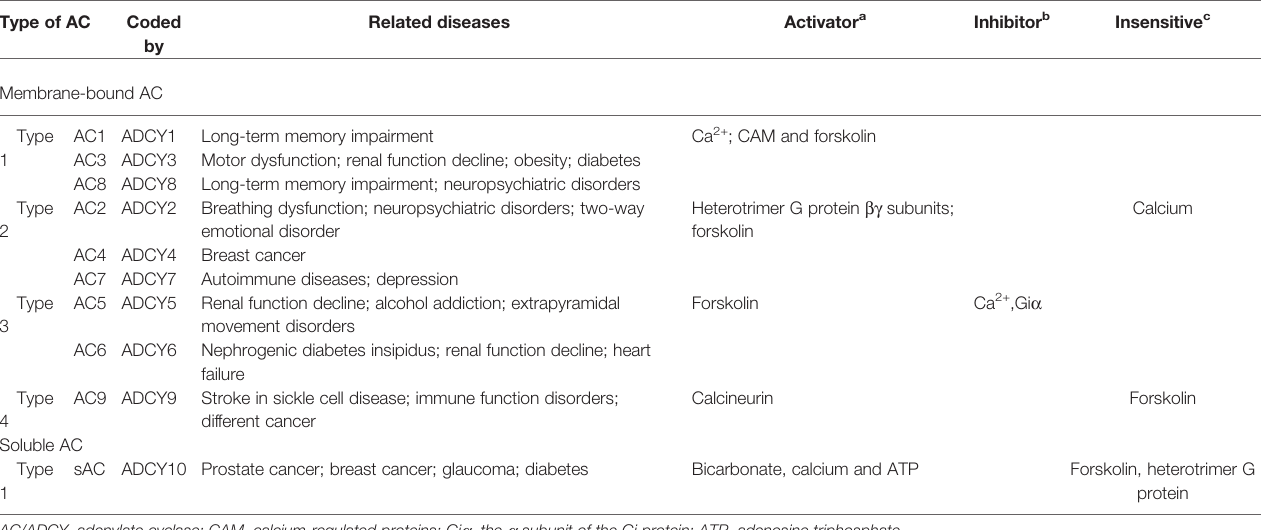
TABLE 1 | Activators or inhibitors for AC subtypes and related